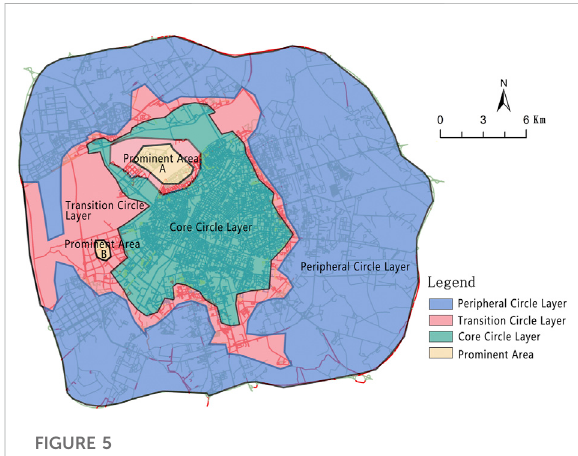
FIGURE 5 The spatial heterogeneity model (SHM) of Harbin ’ s